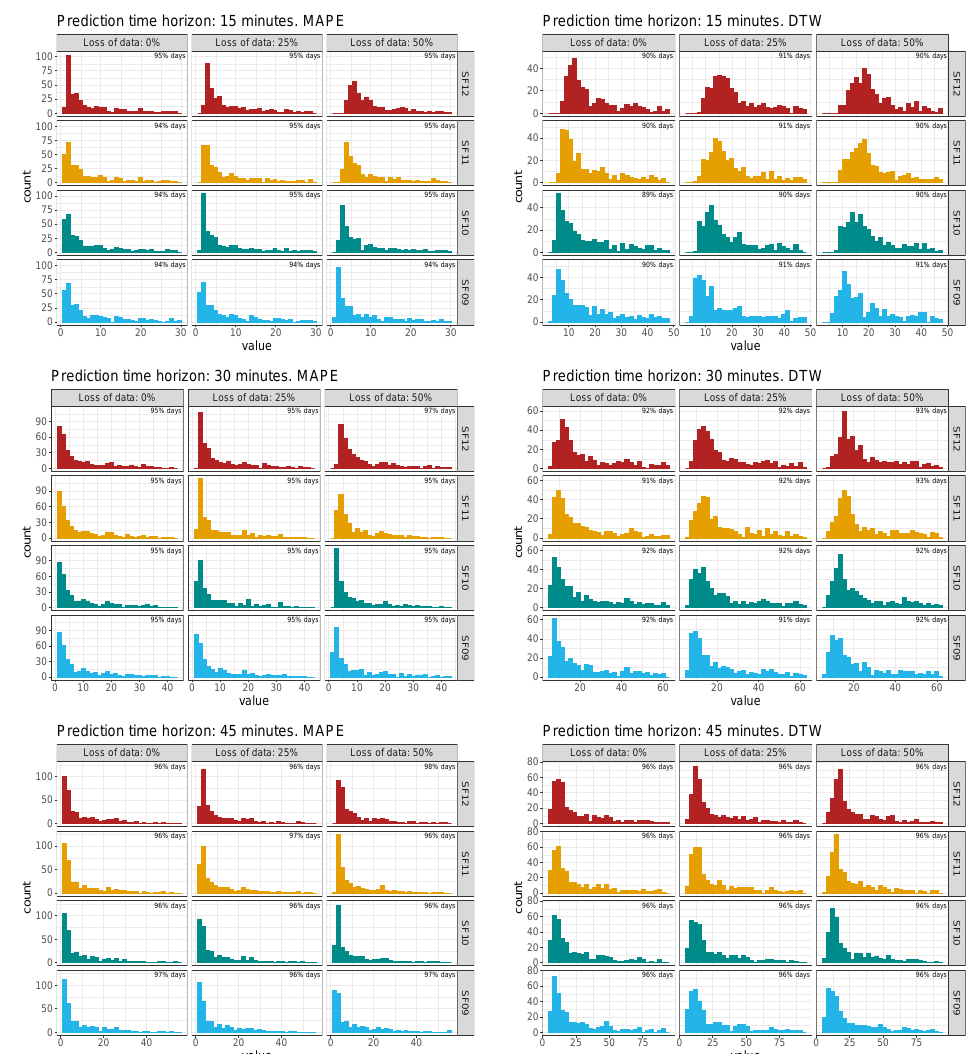
Figure 14. Summary of discrepancies for forecasting and monitoring data based on MAPE and DTW. Truncated